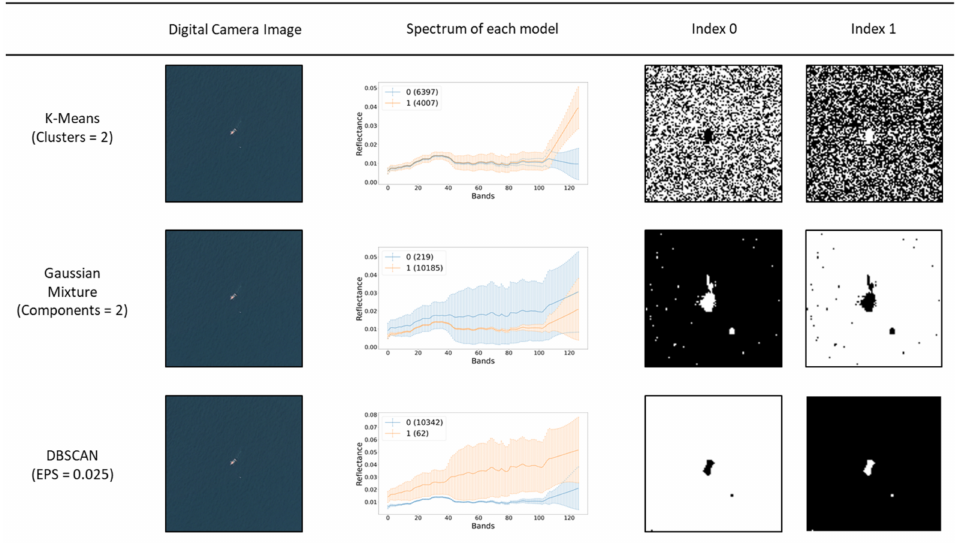
Figure 6. Spectral clustering results of the clustering algorithms. Using target #4 from Figure 5, the spectral clustering results of each clustering model are presented in graphs and images. The area corresponding to the index is indicated in